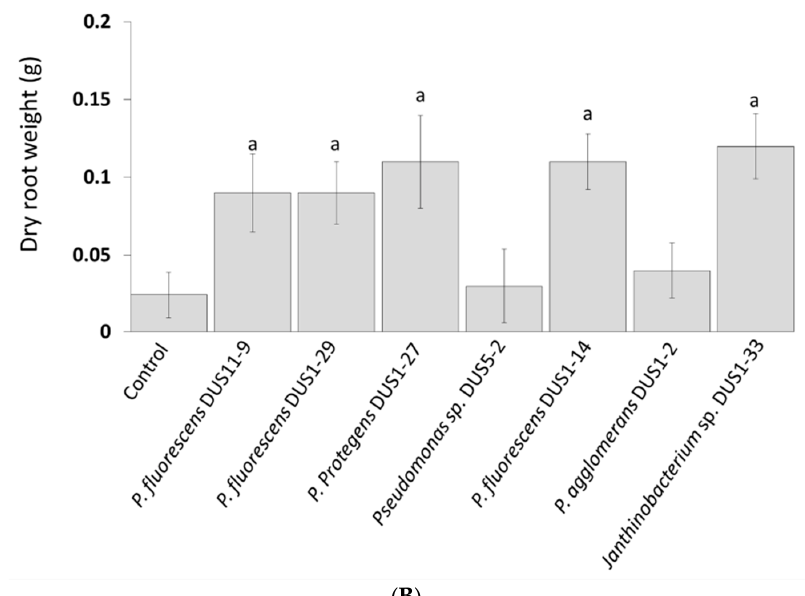
Figure 3. Effect of bacterial isolates on plant shoot ( A ) and root ( B ) biomass after 30 days in a laboratory based growth chamber at 22 °C, a low nutrient sand based medium supplemented with 50% Hoagland and Arnon solution and a controlled water activity of 1.5%. For each strain, 1 × 10 3 CFU of each strain was added when seeds were sown. “a” denotes significant ( p < 0.05) difference in dry shoot and root biomass compared to uninoculated control plants and plants inoculated with Pseudomonas sp. DUS5-2 or P. agglomerans DUS1-2. 3.5. Effect of Bacterial Isolates on Canola Growth after 91 Days of Growth in a Sterile Clay Loam-Based Medium with Normal (8%) and Low (4%) Water Activity Levels Plants were grown for 91 days in a soil-based medium with either 8% or 4% water activity. No alterations in shoot biomass were observed compared to the control for inoculated plants grown in soil with 8% water activity (Figure 4A). For roots of inoculated plants, dry biomass was significantly increased with the addition of the P. fluorescens DUS11-9 and Pseudomonas sp. DUS5-2–by approximately 0.13 g compared to the uninoculated control plant roots (Figure 4B).